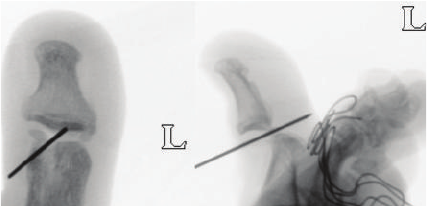
Figure 2: These are intraoperative image-intensifier images of the IP joint of the left great toe showing that interposed sesamoid in the IP joint space caused dorsal dislocation.